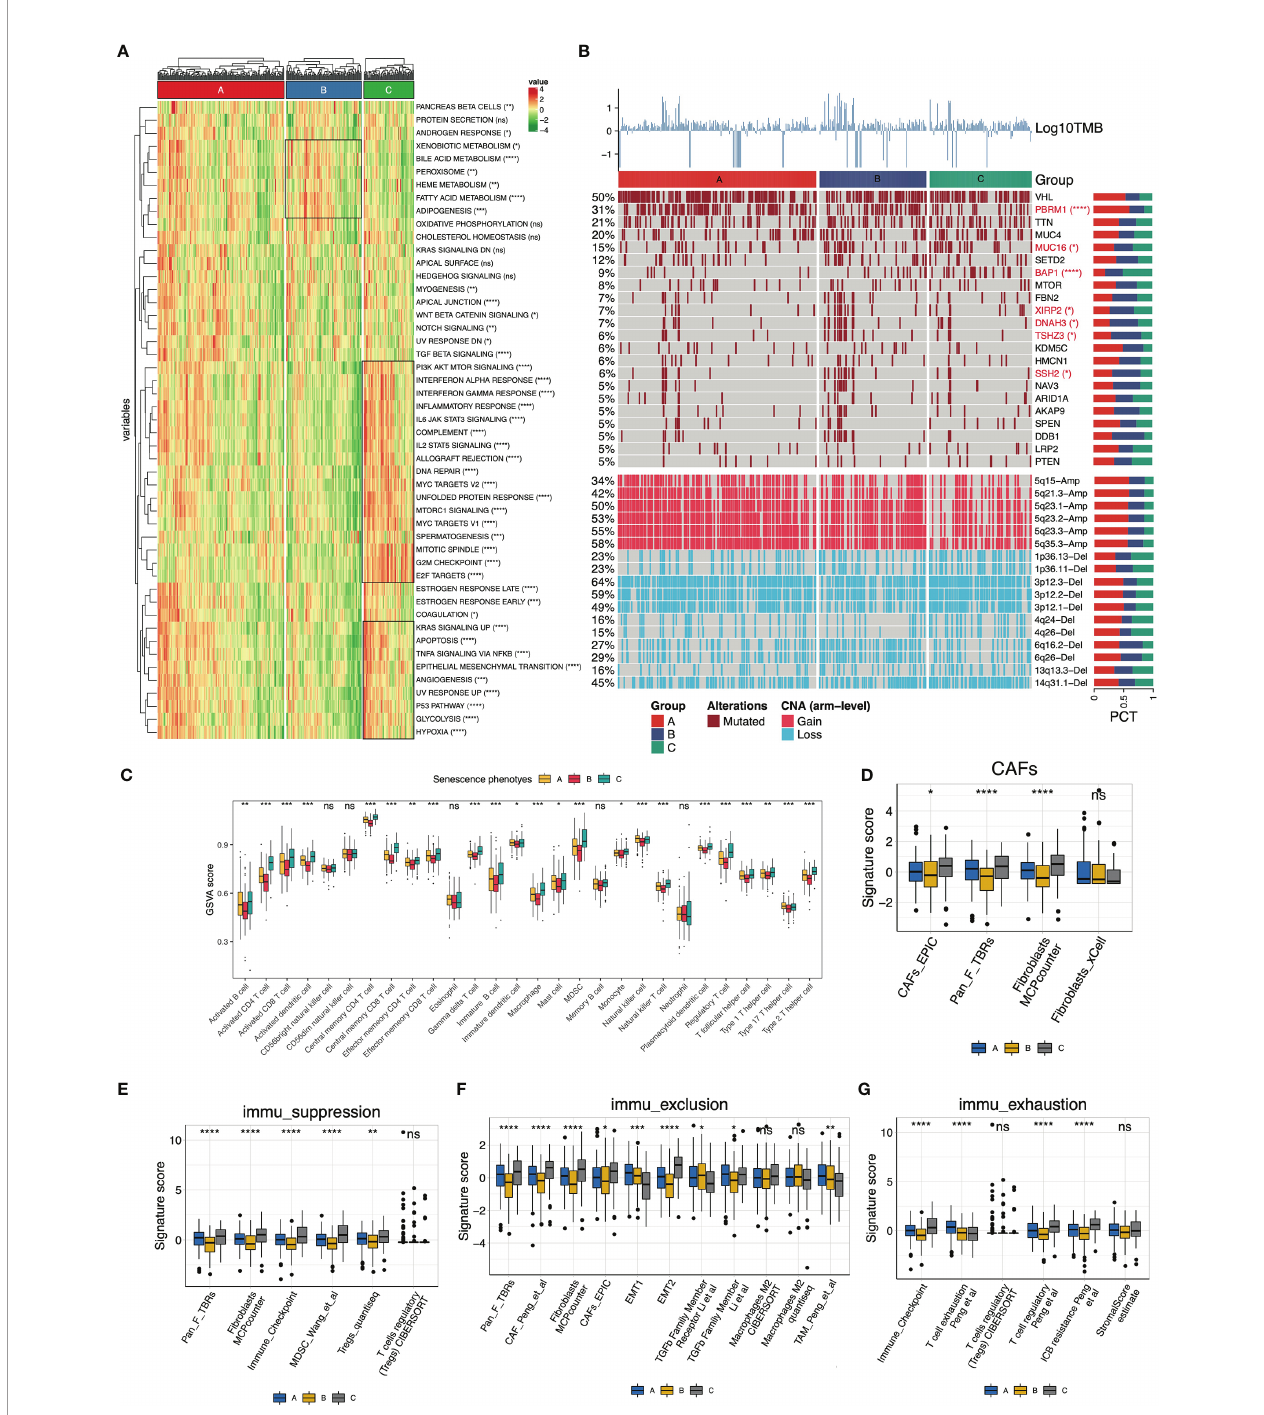
FIGURE 3 | Molecular and immune features of the senescence subtypes of TCGA-KIRC. (A) Heatmap of the cancer hallmarks estimated by the ssGSEA algorithm. (B) Genomic heterogeneity of the senescence subtypes. The heatmap displayed log10TMB, gene mutation pro fi le (frequency >5%), and differentially distributed arm- level copy number variants (CNV) from top to bottom, respectively. The distribution difference was determined by Fisher ’ s exact test. (C) The 28 immune cells (16 adaptive and 12 intrinsic immune cells) were differentially distributed in the senescence subtypes. The in fi ltration abundance was estimated by the ssGSEA algorithm. (D – G) Signature panels calculated using the “ IOBR ” package, (D) Cancer-associated fi broblasts (CAFs), (E) immune suppression, (F) immune exclusion, and (G) immune exhaustion signatures. The level of statistical difference was labeled with ns, *, **, ***, and ****, which represents no statistical difference, p < 0.05, p < 0.01, p < 0.001, and p < 0.0001,